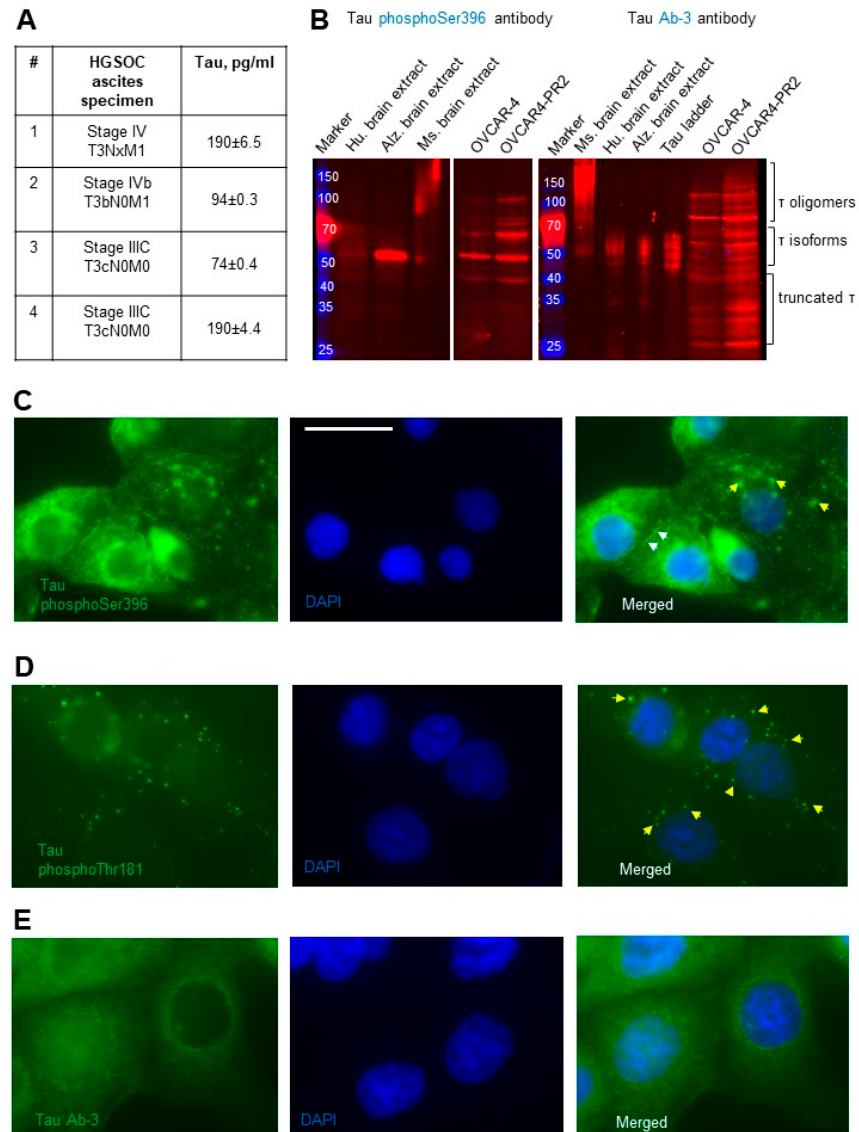
Figure 2. Detection of secreted and phosphorylated tau in HGSOC ascites and cell lines. ( A ) Total tau was measured by ELISA in specimens from patients with advanced and metastatic HGSOC and derived in pg/mL. ( B ) Expression of tau was examined with Western blot using tau phosphoSer396 antibodies (1:1000 dilution) and tau Ab-3 antibodies (1:100 dilution) in the parental and paclitaxel-resistant cells. Mouse and human brain extracts (20 µ g/lane) and tau ladder consisting of 6 tau isoforms were used as positive controls. The loading control (vinculin) for OVCAR-4 and OVCAR4-PR2 is shown in Figure 1A. The uncropped blots are shown in File S1. ( C ) Tau phosphoSer396 primary antibodies (1:100 dilution) and anti-rabbit DyLight488 secondary antibodies were used to detect subcellular localization of the phosphoSer396 tau species in OVCAR-4 by immunofluorescence staining. Nuclear DNA was detected by staining with DAPI. Images were acquired using Zeiss fluorescence microscope. Left panel—tau (green), center panel—DAPI (blue). Right panel: images of tau and DAPI were superimposed using Zeiss Axiovert software. Bar, 25 micron. Yellow arrows point to tau in the cytoplasm, and white arrows point to tau on the cell surface. ( D ) Tau phosphoThr181 primary antibodies (1:100 dilution) and anti-mouse AlexaFluor488 secondary antibodies were used to detect subcellular localization of the tau species (green fluorescence) in OVCAR-4 with immunofluorescence staining. Nuclear DNA was detected by staining with DAPI. Images were acquired using Zeiss fluorescence microscope. Left panels—tau (green), center panels—DAPI (blue). Right panels: images of tau and DAPI were superimposed using Zeiss Axiovert software. Yellow